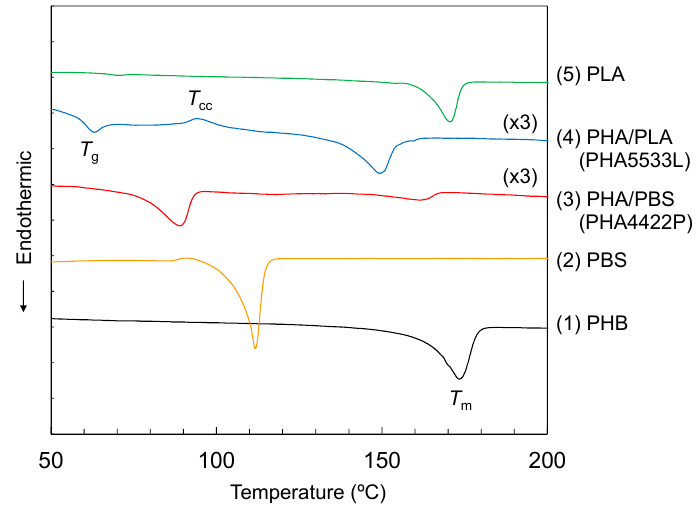
Figure 2. Differential scanning calorimetry (DSC) heating curves of plasticized PHA copolymers and constituent polymers.